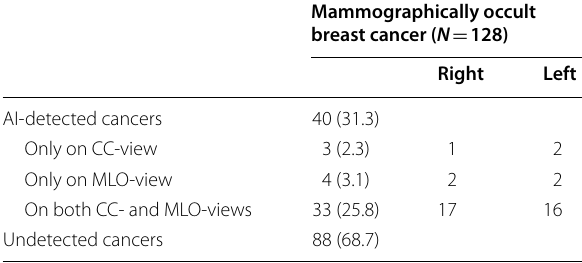
Unless otherwise indicated, data represent the numbers of patients, with percentages in parentheses AI artificial intelligence, CC craniocaudal, MLO mediolateral